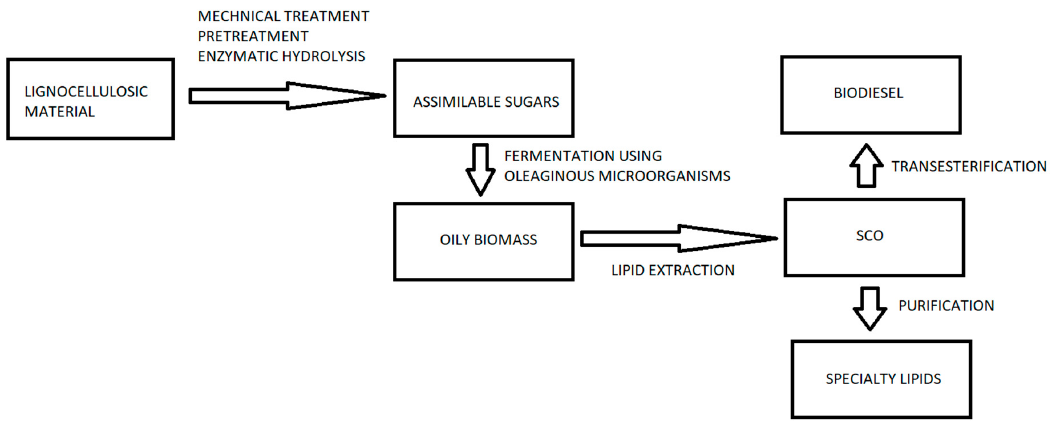
Figure 3. A simplified flow chart of an industrial process for the production of lipids from lignocellulosic biomass using oleaginous microorganisms.